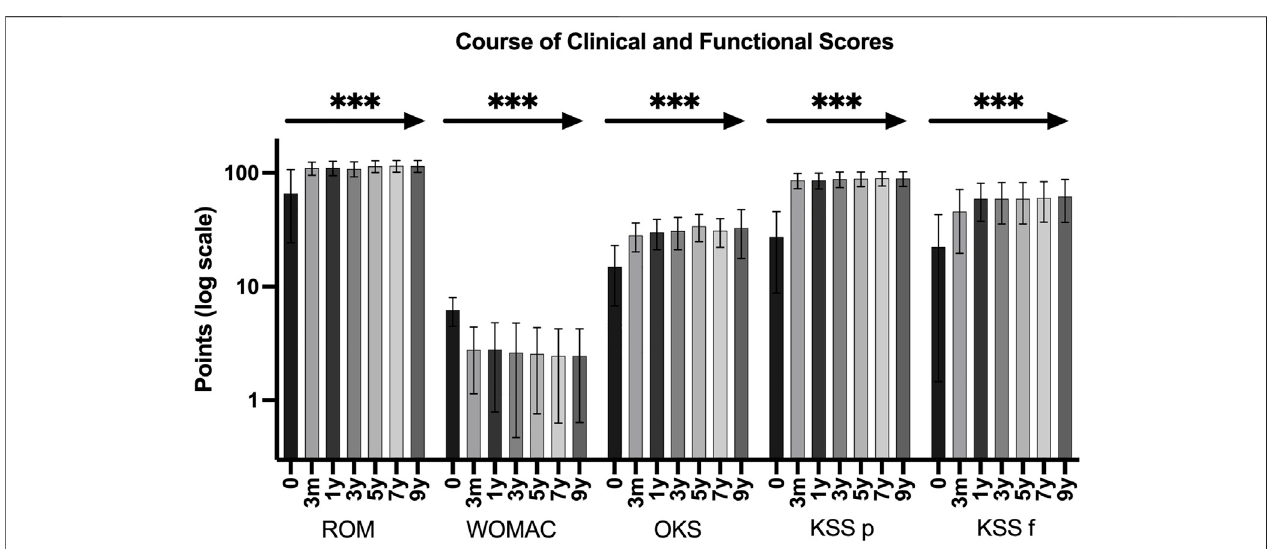
FIGURE 1 | Clinical function and scores preoperative (0 months) and at 3 months, 1, 3, 5, 7, and 9 years after surgery. Clinical function and scores signi fi cantly improvedfrompreoperativevaluesto3 monthsaftersurgeryandsustainedatthesamelevelovertheentireobservationalperiod.Theasteriskandthearrowindicatethe comparison between preoperative and each postoperative values separately (*** ... p < 0.0001).